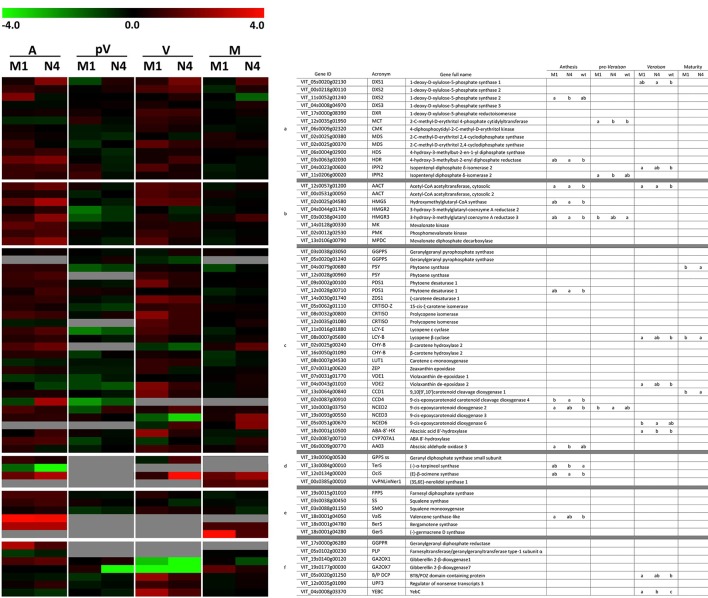
Relative expression matrix of the terpenoid pathway genes assayed by the Aromix_TaqMan array card in transformed and WT microvines during fruit development. Columns represent the transformed lines (M1 = Mi-M1, N4 = Mi-N4) at different stages (A, anthesis; pV, pre-veraison; V, veraison; M, maturity), while rows represent the genes grouped into six blocks related to terpenoid pathways: (a) MEP, (b) MVA, (c) carotenoids/apocarotenoids, (d) monoterpenes, (e) sesquiterpenes and (f) others (chlorophyll, gibberellin, isoprene, tocopherol, etc). Each element of the matrix indicates the log2 expression fold change in Mi-M1 or Mi-N4 lines compared to WT by means of a color code (heatmap). To this purpose, the raw Cq values of each line were considered stage by stage. The associated relative expression, which is the mean of two biological replicates both analyzed in duplicate, was calculated with the qBasePLUS software and is reported in Table S3 (at maturity only one WT biological replicate was available). Gray spaces correspond to not detectable transcripts. The heatmaps were generated with TM4 Multi experiment viewer (MeV) software (Saeed et al., 2003). The letters in the last four columns indicate different subsets according to ANOVA and LSD tests (anthesis, pre-veraison, veraison) and t-test (maturity) (P < 0.05).